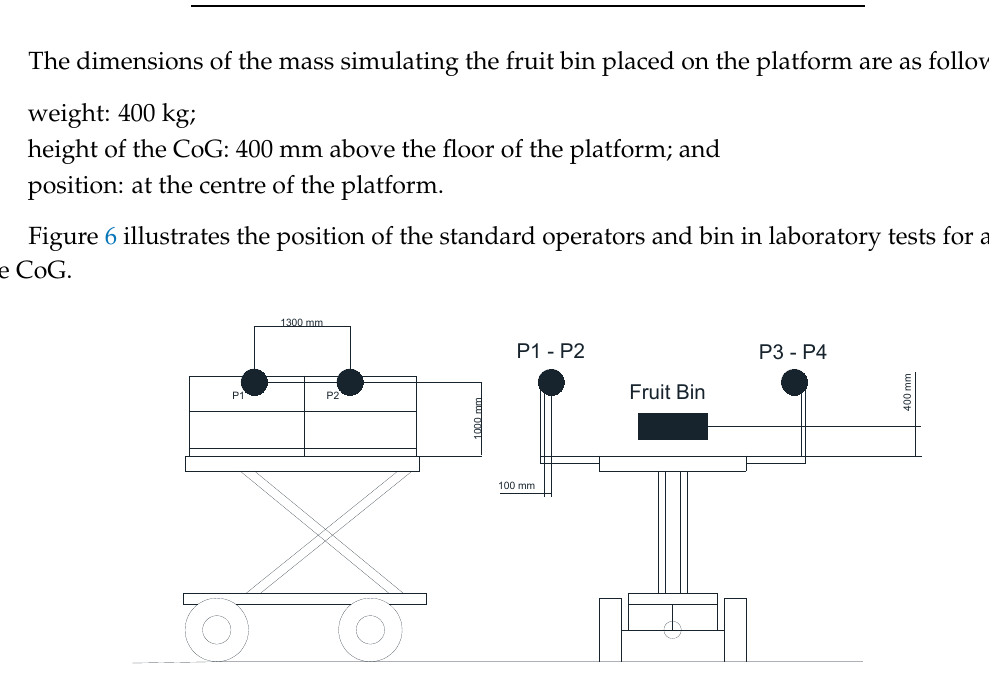
Figure 6. Scheme of the masses on the platform during CoG assessment (P1, P2, P3, and P4 are the operators).